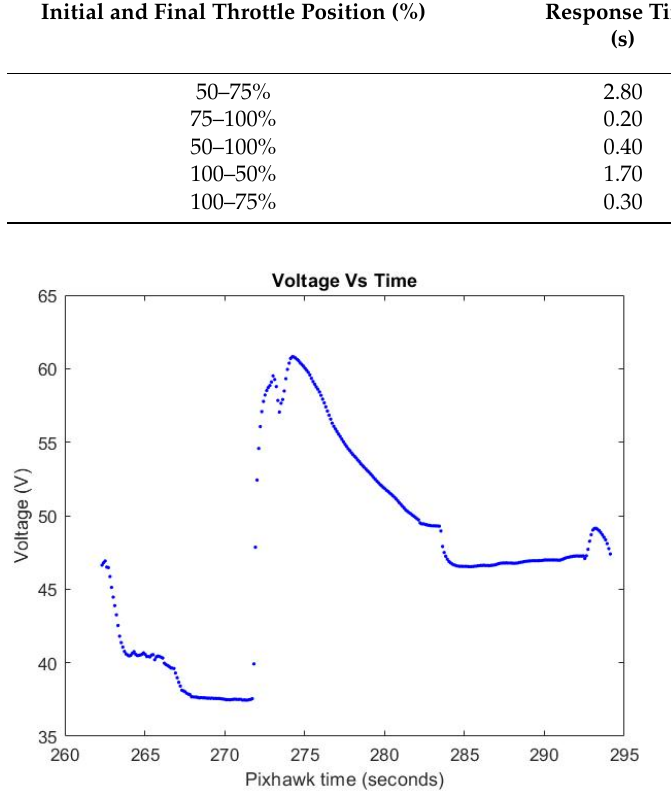
Figure 15. The voltage plot was produced with a 100% throttle load cutoff test.